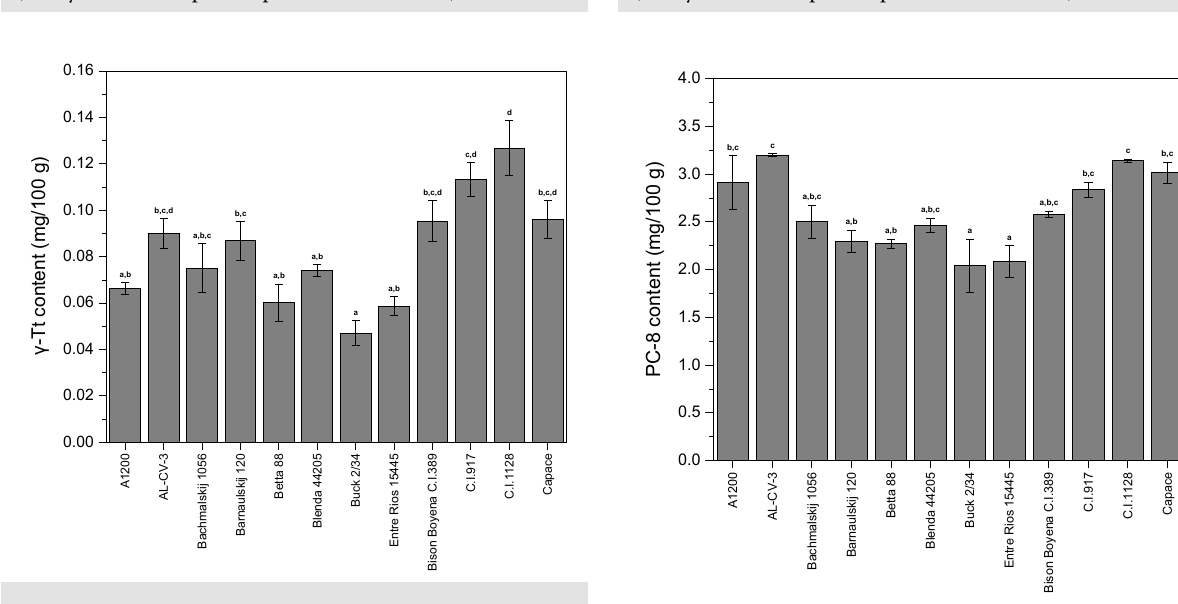
Fig. 1 Gamma-tocotrienol (γ-Tt) content in accessions of flax (Group I). Different letters indicate significant differences (Tukey’s HSD multiple comparison test, α = 0.05).